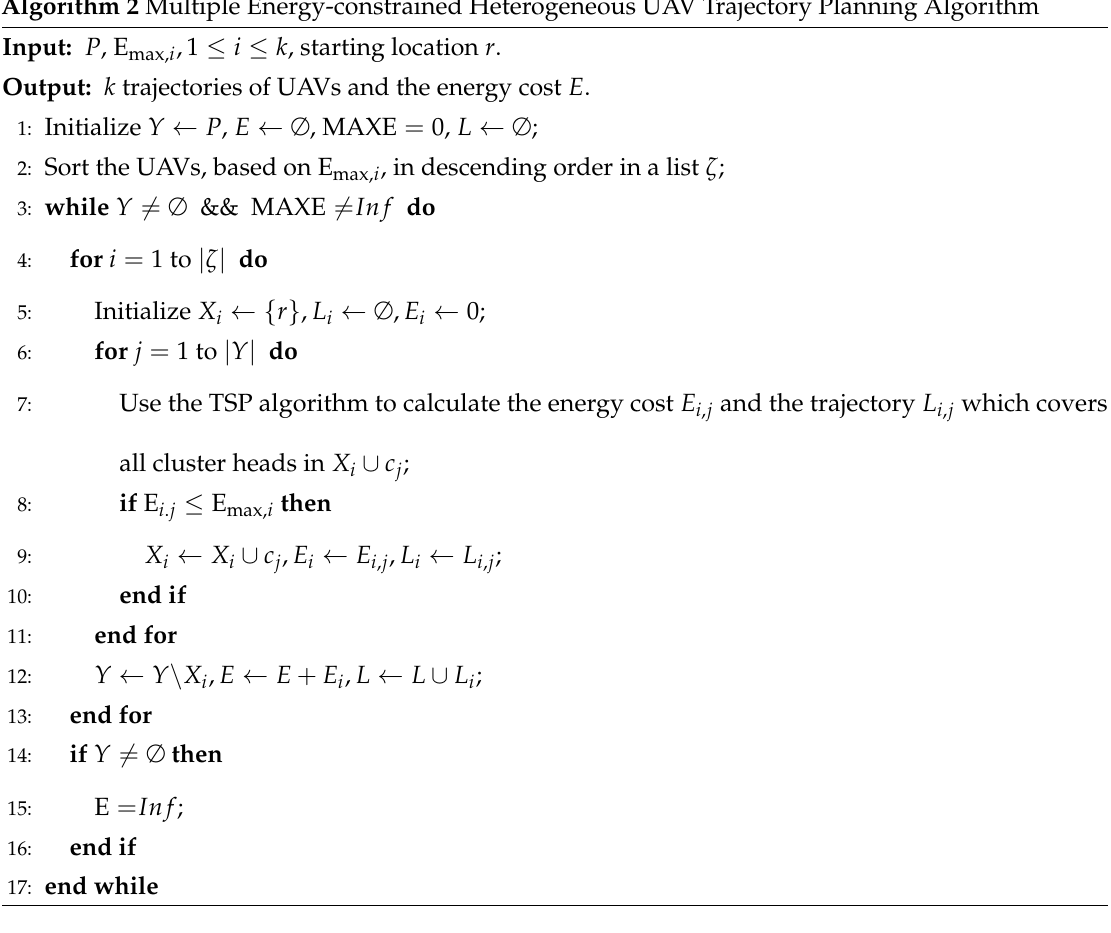
Algorithm 2 Multiple Energy-constrained Heterogeneous UAV Trajectory Planning